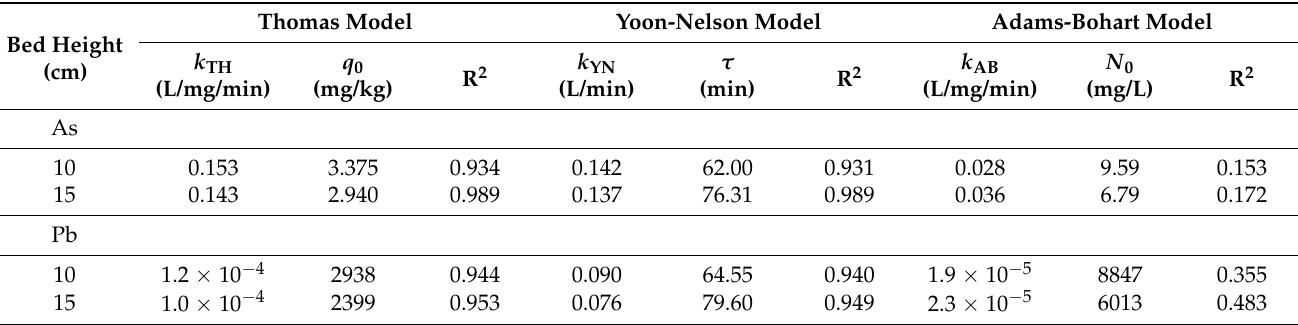
Table 4. Parameters of Thomas, Yoon-Nelson, and Adams-Bohart models for As and Pb at different bed height experiment.